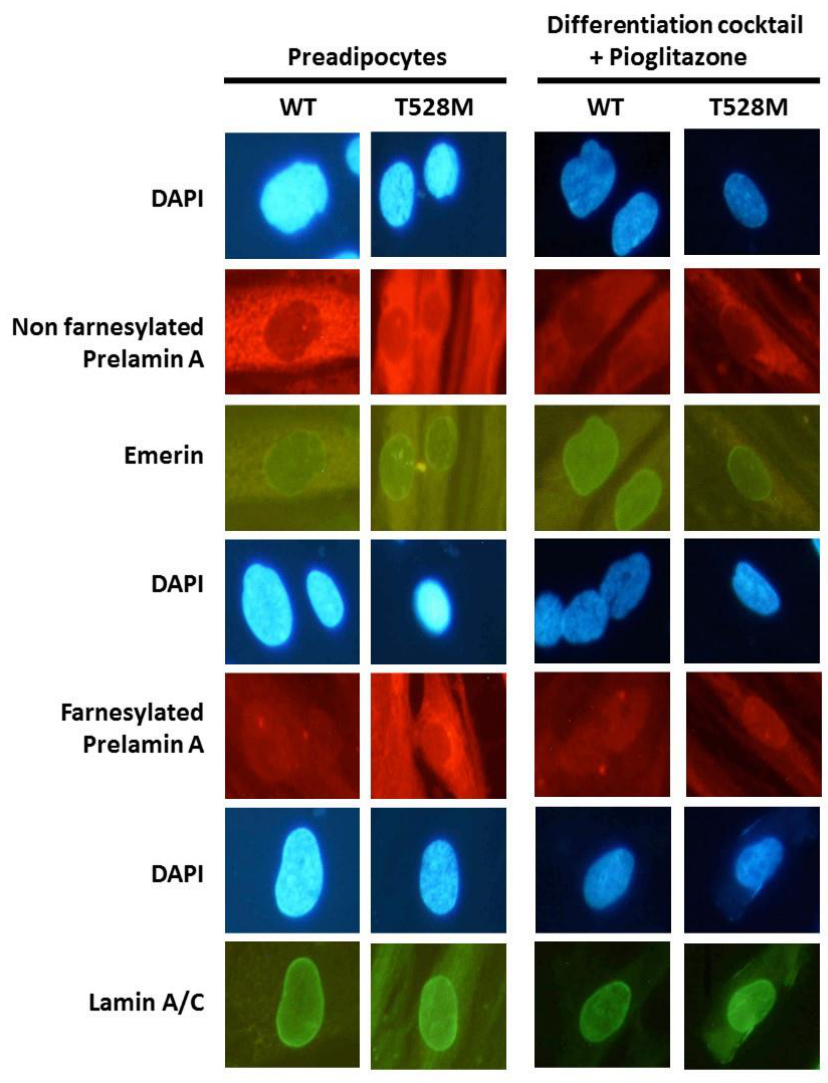
Figure 6. Immunofluorescence images of representative preadipocytes and differentiated adipocytes. All images were photographed at 20-fold magnification.